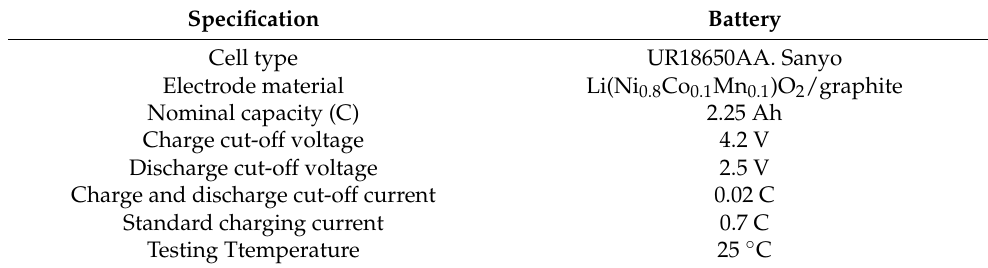
Table 1. Specifications of the battery.